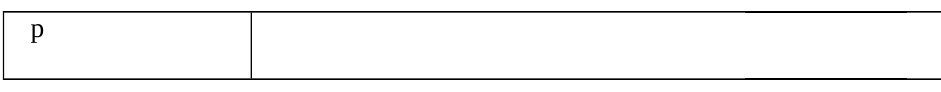
Table (4): Comparison between the two studied groups regarding skin type and sun exposure.